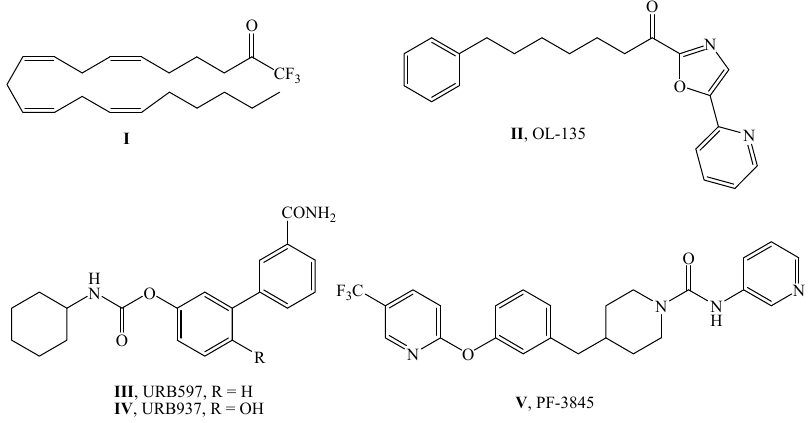
Figure 1. Structures of FAAH inhibitors.